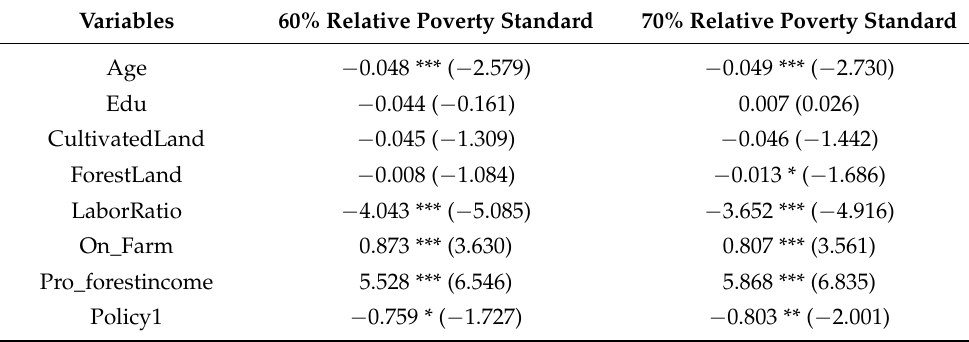
Table 9. The Logit regression results under the 60% and 70% relative poverty standard.